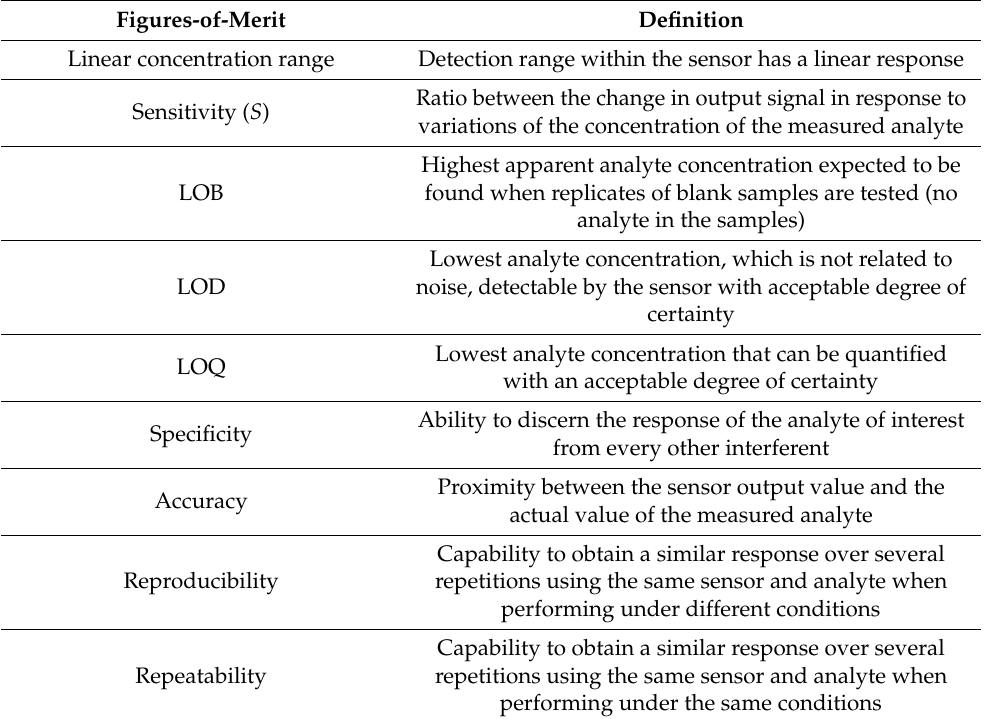
Table 1. Figures-of-merit of